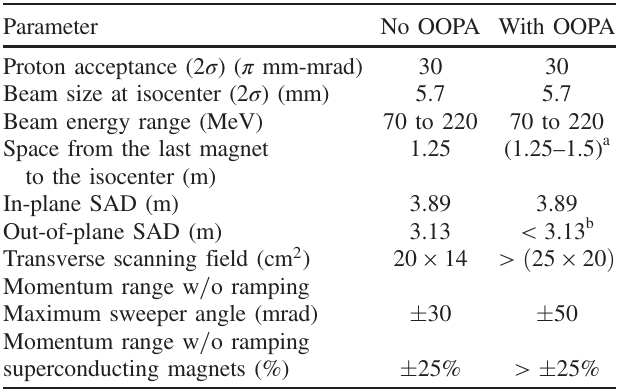
TABLE X. Summary of simulation results for a gantry without and with an out-of-plane assist (OOPA) sweeper. Parameter No OOPA With OOPA